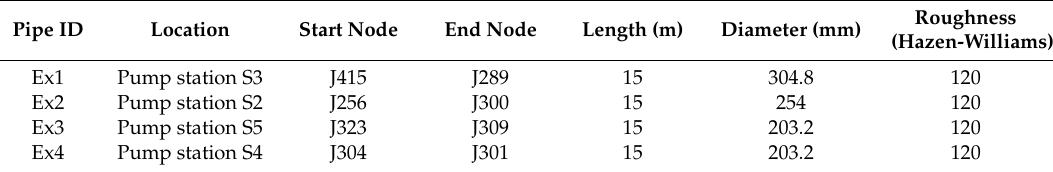
Figure 6. ( A ) The case study water distribution system (WDS)—the C-Town; ( B ) the network motif of C-Town; and ( C ) the motif-based visualization of C-Town. Table 2. Information of the four extra